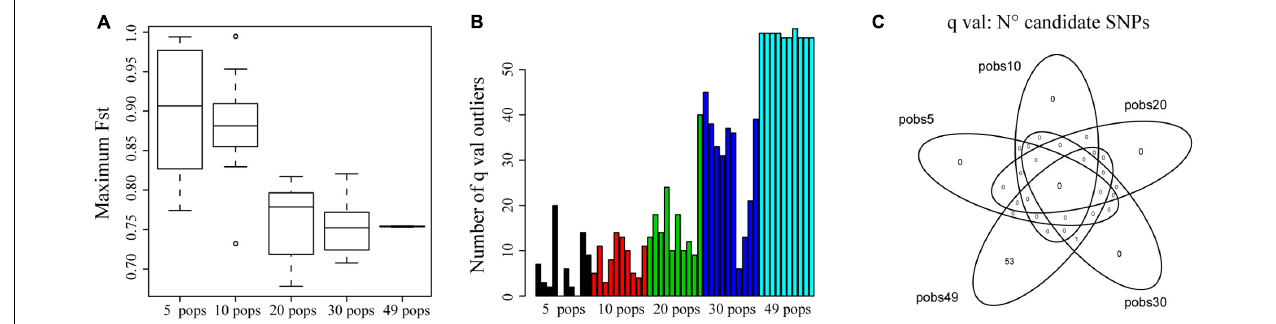
FIGURE 5 | The effect of sampling a different number of populations on the identification of outlier SNPs. (A) Distribution of the highest F ST identified for a locus across simulations. (B) Number of outlier SNPs ( q-val ) identified for each replicate for a different number of sampled populations. (C) The Venn diagram shows the number of shared SNPs identified across replicates and the number of populations sampled using q-val to identify